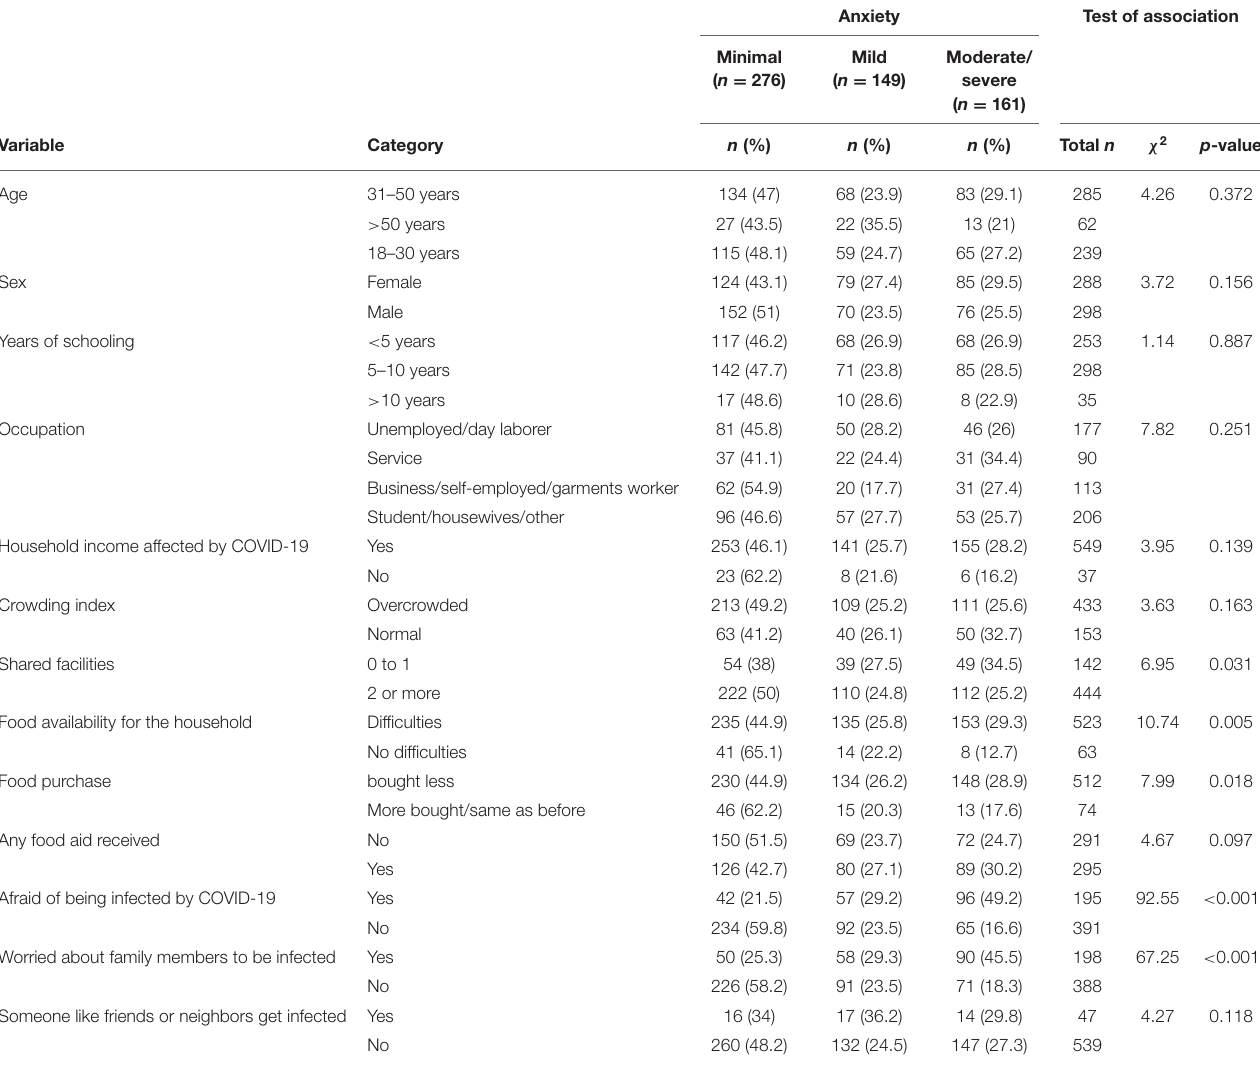
TABLE 2 | Associations between independent variables and levels of anxiety.